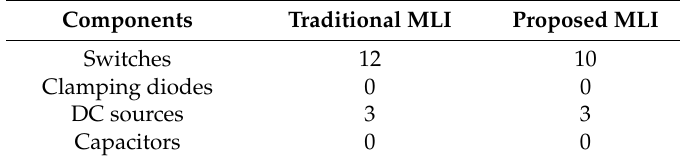
Table 2. Component requirements for existing and proposed cascade MLI systems.